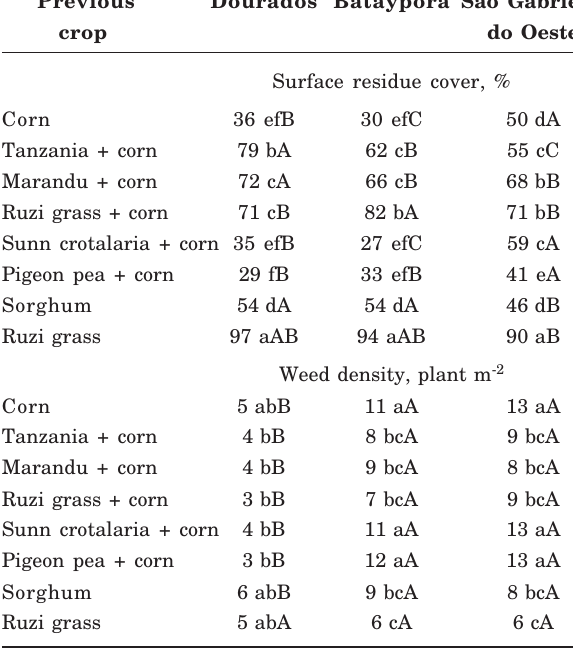
Table 5. Surface residue cover and weed density 10- 15 d after soybean planting as affected by the previous crop in 2005 at three locations in Mato Grosso do Sul, Brazil